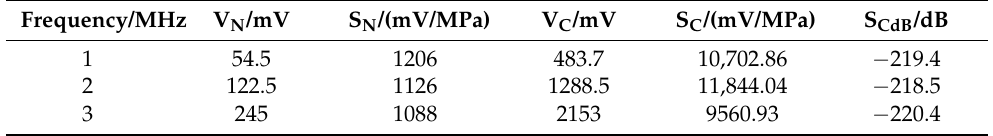
Table 3. Experiment results of unpackaged CMUT receiving sensitivity